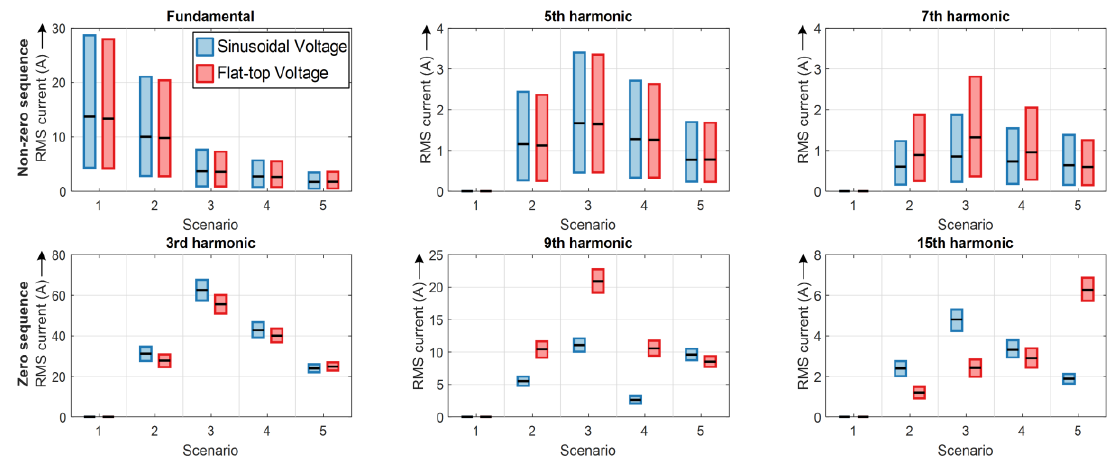
Figure 9. Comparison of selected neutral harmonic currents at analysis point 1.